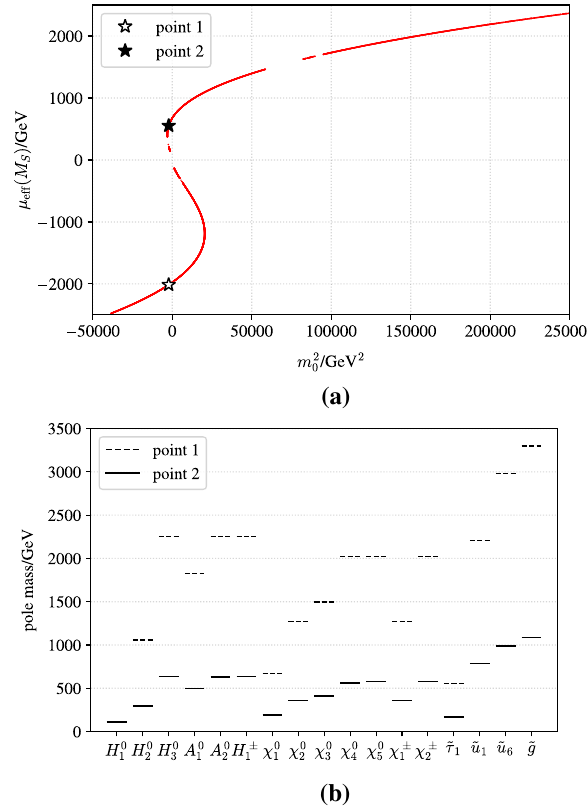
Fig. 13 Two parameter points fulfilling the CNMSSM boundary con- dition given in Eq.(31). The points differ in their values for μ eff , M 1 / 2 , and A 0 (see Table2), which results in two vastly distinct pole mass spectra shown in ( b